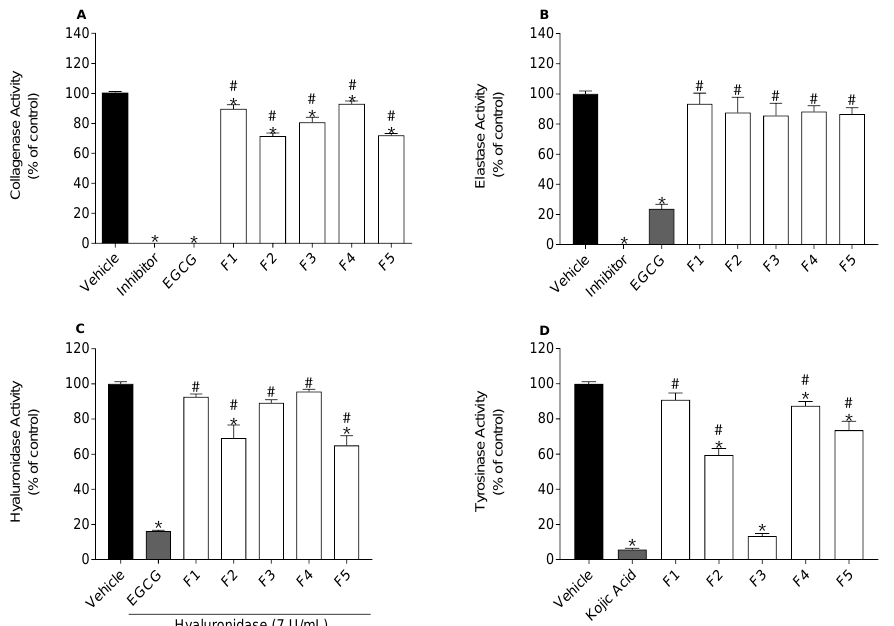
Figure 2. Enzymatic inhibitory activity of Saccorhiza polyschides fractions (200 µg/mL) on collagenase ( A ), elastase ( B ), hyaluronidase ( C ) and tyrosinase ( D ). Epigallocatechin gallate (EGCG) was used as the positive control of collagenase, elastase and hyaluronidase. Kojic acid was used as the positive control of tyrosinase. Symbols represent significant differences (one-way ANOVA, Dunnett’s test; p < 0.05) when compared to vehicle (*) and EGCG or kojic acid (#). For fraction F3 that inhibited tyrosinase activity by more than 50%, its IC 50 value was determined, and the dose-response curves are shown in Figure 3.